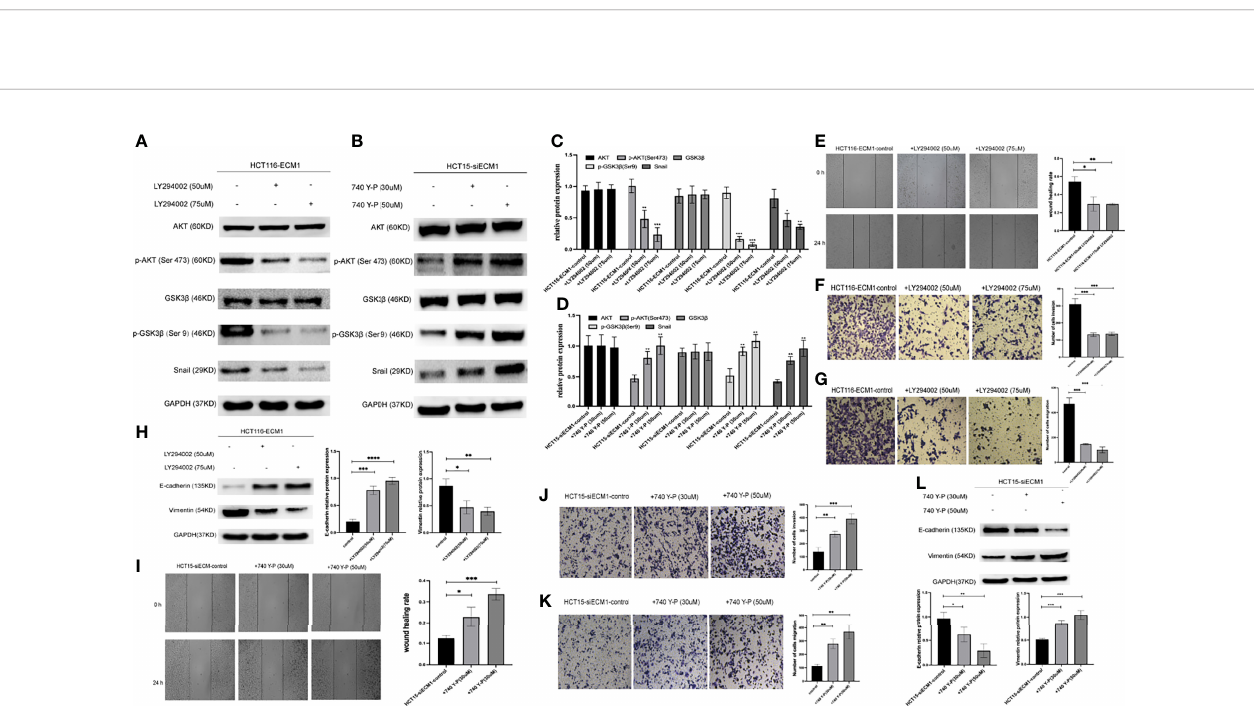
FIGURE 7 | PI3K/AKT agonist and inhibitor treatment can reverse the effects of altered ECM1 expression on CRC cells. HCT116-ECM1 were treated for 24 h with LY294002 (50 or 75 uM), or HCT15-siECM1 were treated 24 h with 740 Y-P (30 or 50 uM), after which invasive and migratory activity were assessed through Transwell and wound healing assays (E – G, I – K) , while Western blotting was used to assess AKT, p-AKT, GSK, pGSK, Snail, E-cadherin, and Vimentin expression (A – D, H,L) . Data are means ± SD (*P < 0.05, **P < 0.01, ***P < 0.001, ****P